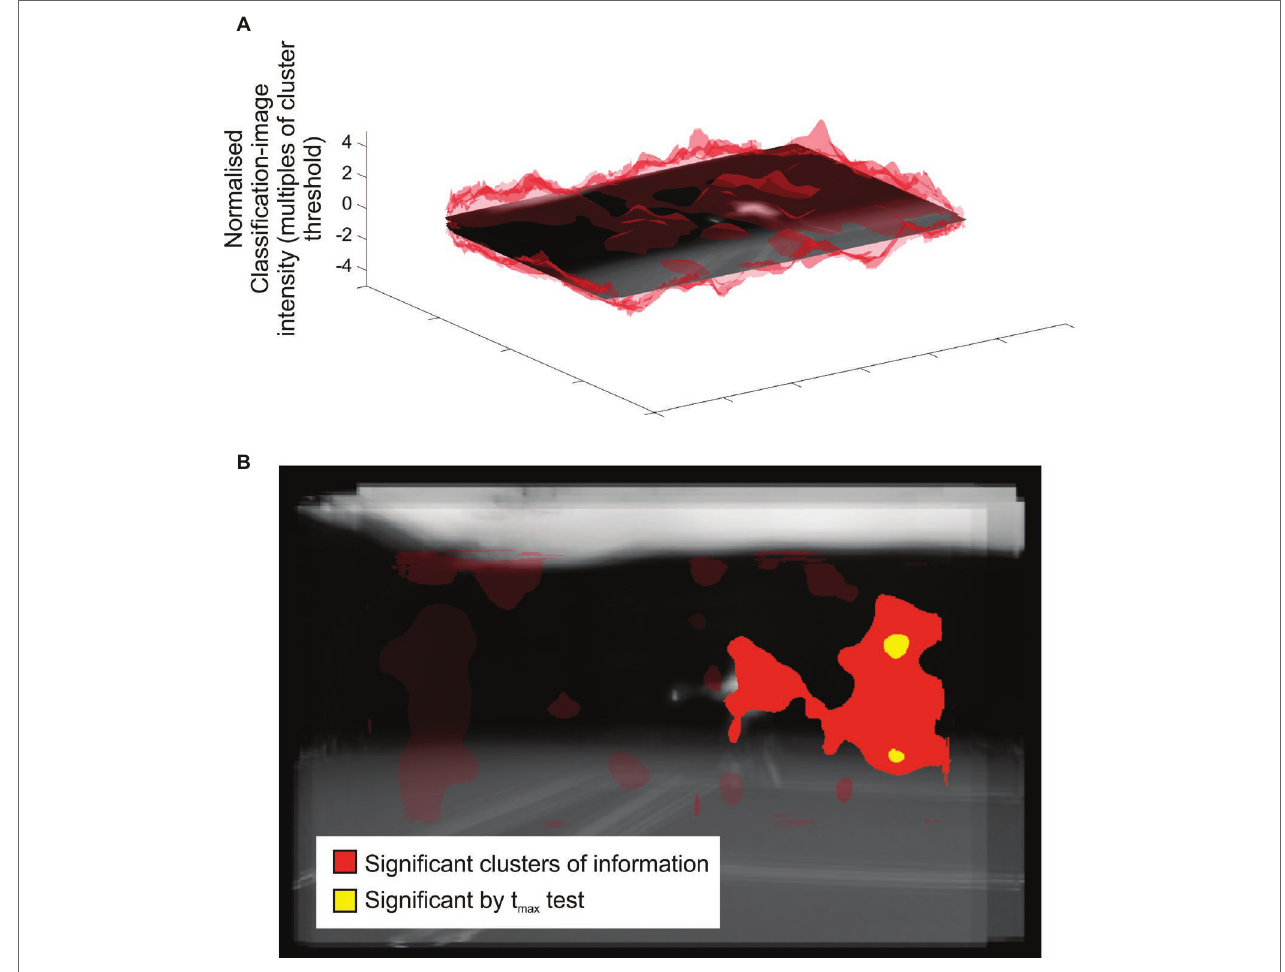
FIGURE 3 | Classification image results from the spatial bubbles experiment. Results are overlaid on an image of the mean of all presented videos for the frames capturing racket-ball contact, centered on the point of racket-ball contact (hence constituent images do not perfectly align). However, the results of the spatial analysis are not specific to any one time point. (A) Transparent red peaks denote mean classification-image intensity normalized to the cluster threshold value used in permutation testing (i.e., values more extreme than ±1 formed potential clusters). (B) Solid colored regions were significant in cluster/ t max permutation testing, suggesting information might have been extracted from this part of the video. Transparent red regions denote nonsignificant